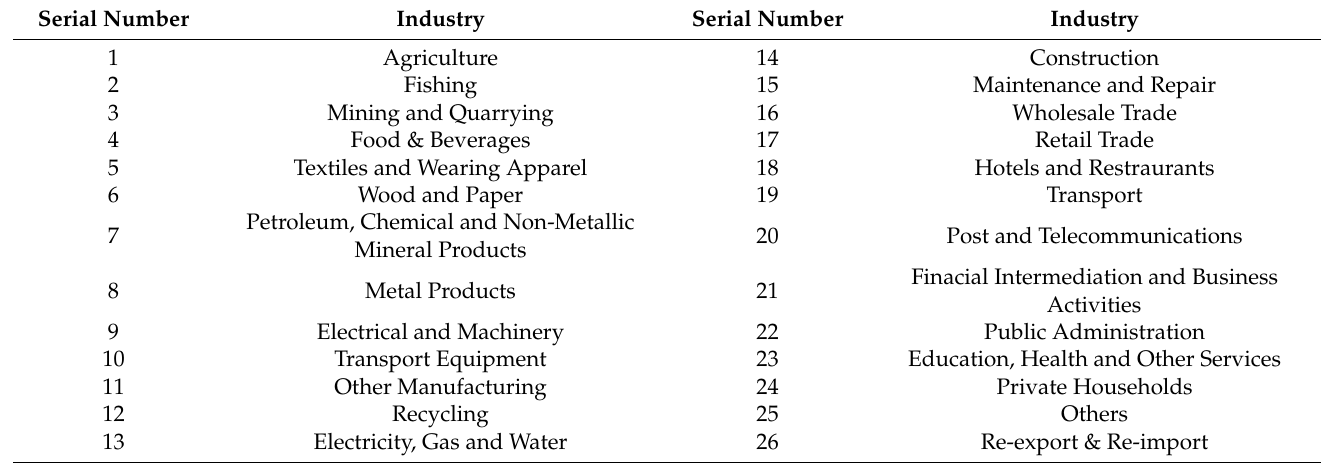
Table 1. Industries after